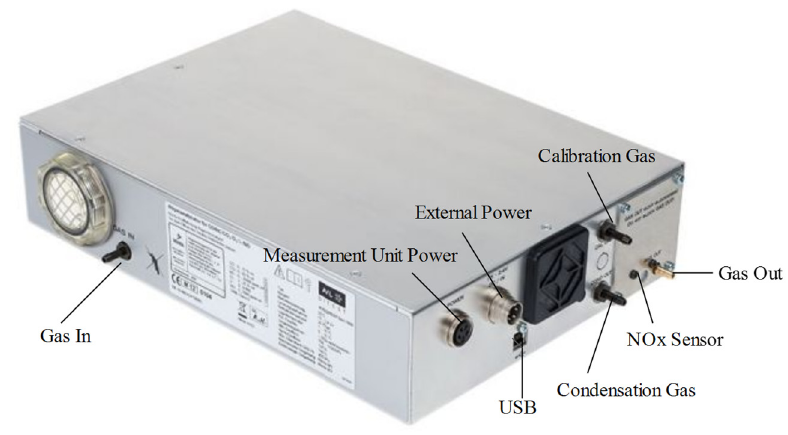
Figure 11. The measurement unit of the AVL di-test gas 1000 analyzer.